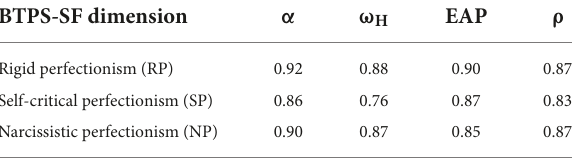
Rigid perfectionism (RP) 0.92 Self-critical perfectionism